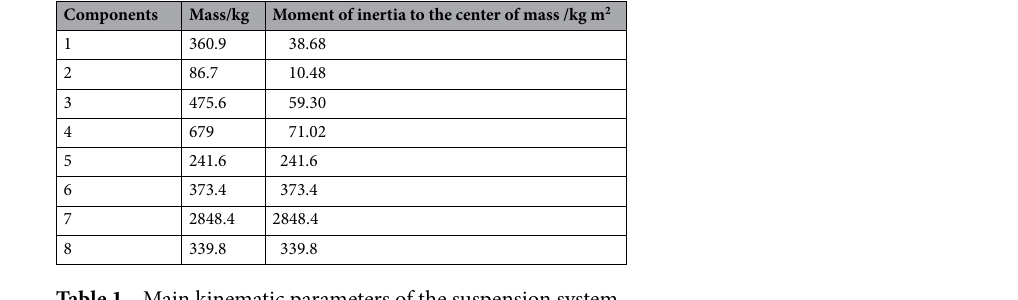
Table 1. Main kinematic parameters of the suspension system.